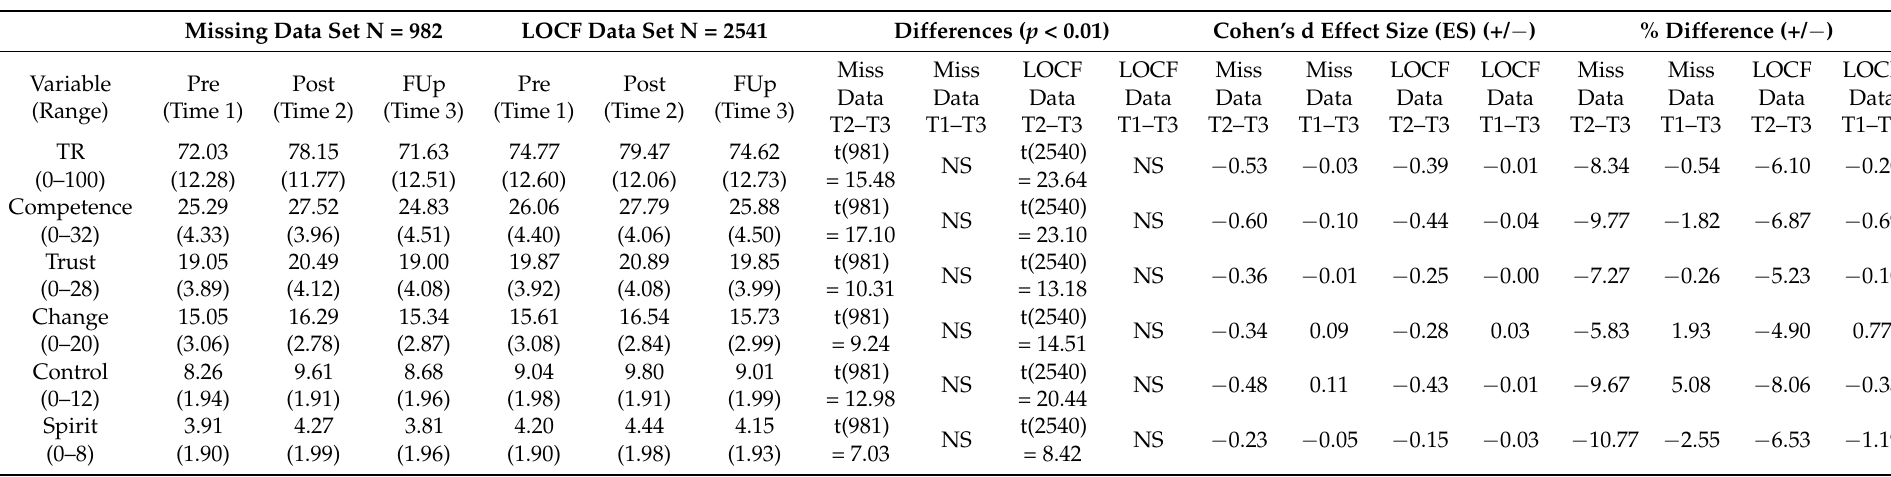
Table 3. Mean Total Resilience (TR) subscale paired mean differences, effect sizes and percentages between specific time-points for both data